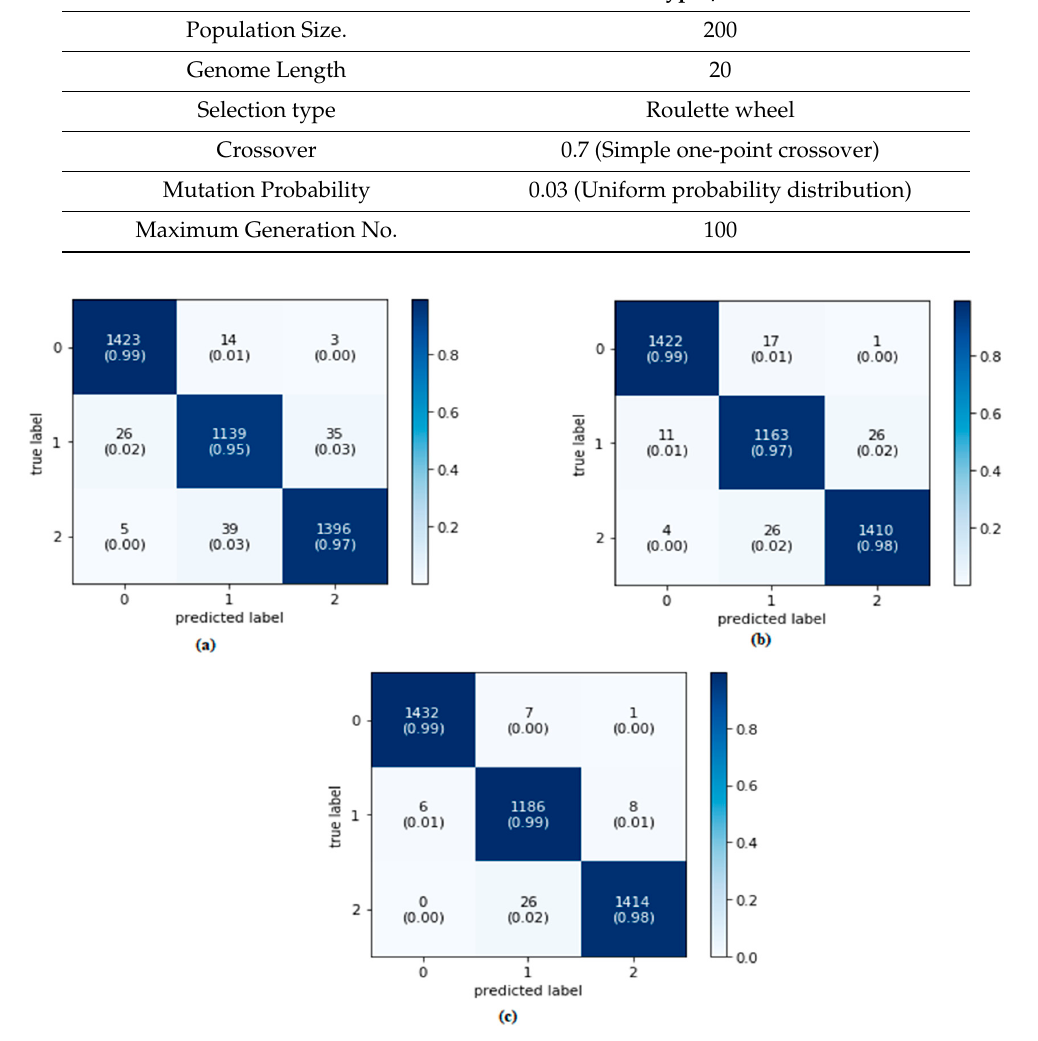
Figure 11. Confusion matrix for ( a ) KNN, ( b ) decision tree, and ( c ) random forest classifiers.